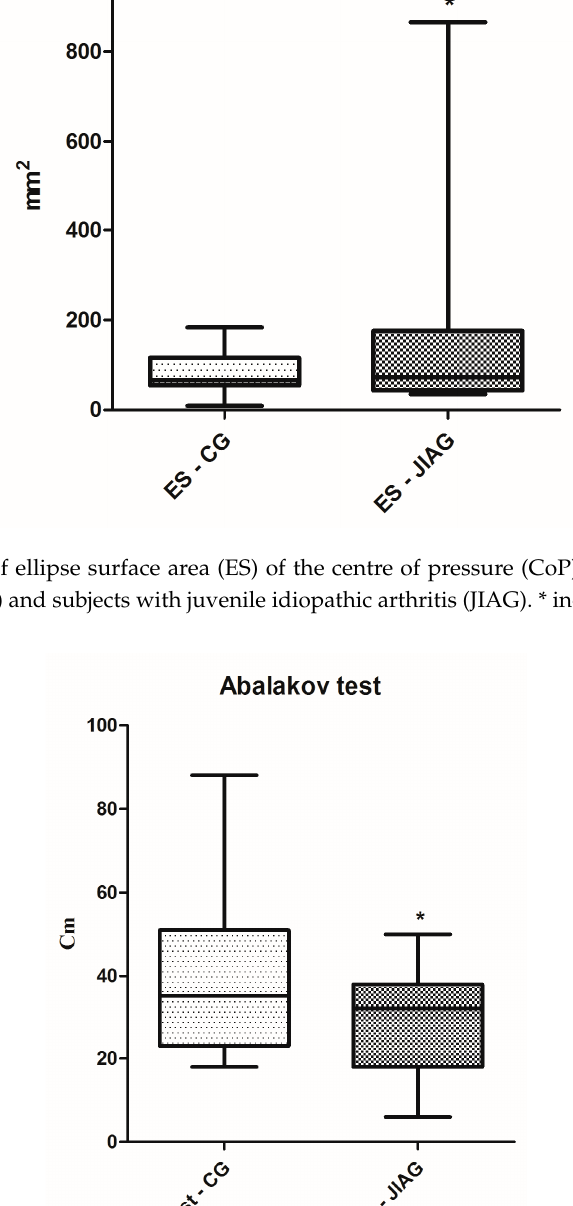
Figure 1. Analysis of length of sway path (SP) of the centre of pressure (CoP) among the group of healthy subjects (CG) and subjects with juvenile idiopathic arthritis (JIAG). *** indicated that p < 0.0001